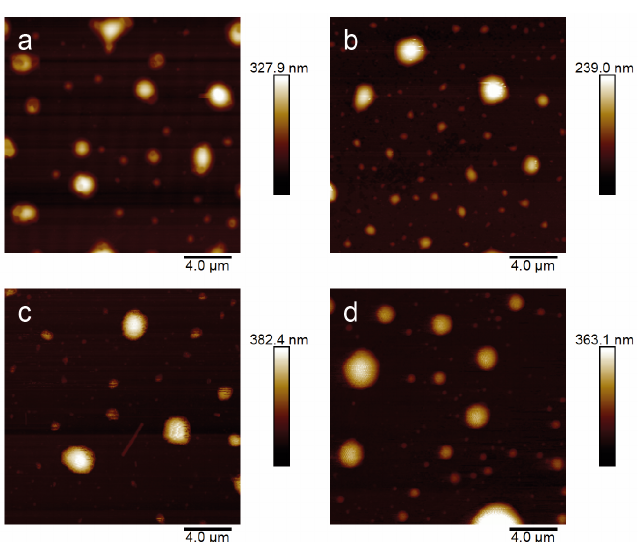
Figure 2. Atomic force microscopy (AFM) images related to: NioTw20 ( a ), NioTw20 + AgNPs ( b ), NioSp20 ( c ), and NioSp20 + AgNPs ( d ).